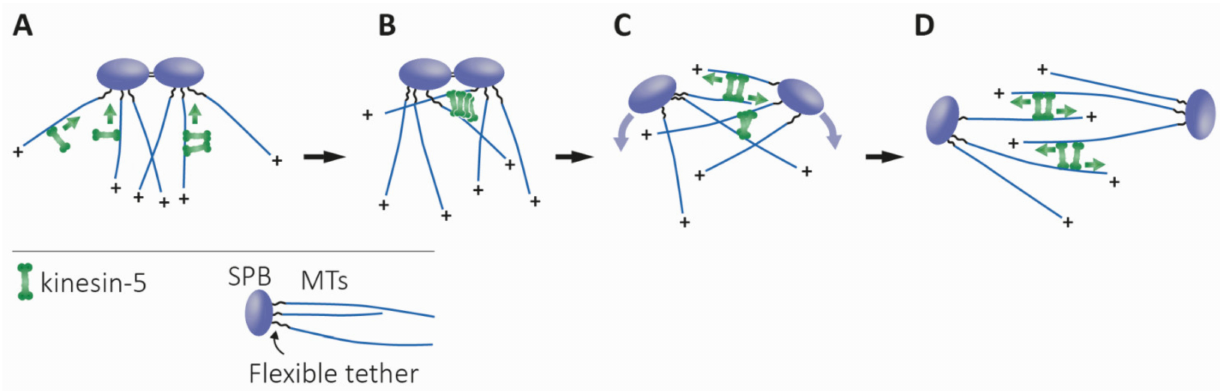
Figure 5. Proposed model for the physiological role of the bidirectional motility of fungi kinesin-5 motor proteins, adapted from [62]. ( A ) Prior to spindle assembly, the minus-end directed motility of bidirectional kinesin-5 motors causes their accumulation at the minus-ends of the MTs, near the SPBs. ( B ) At this stage, MTs from duplicated spindle poles come into antiparallel contact due to thermal pivoting, facilitated by flexible tether linking MT minus-ends and the SPB [235]. Kinesin-5 motors, accumulated in clusters near the SPBs, capture these antiparallel-oriented MTs, crosslink, and slide them apart via their plus-end directed motility. This plus-end directed motility is achieved by the clustering of kinesin-5 motors near the spindle poles and the binding to the two antiparallel MTs [62,148]. ( C ) The initial separation of the spindle poles, caused by the antiparallel sliding of MTs, generates additional MT overlap—which creates additional sites for the kinesin-5 motors to crosslink and slide apart antiparallel MTs. ( D ) Formation of the final bipolar spindle structure is achieved. The curved purple arrows indicate the direction of SPB movement during separation. Green arrows indicate the direction of motor